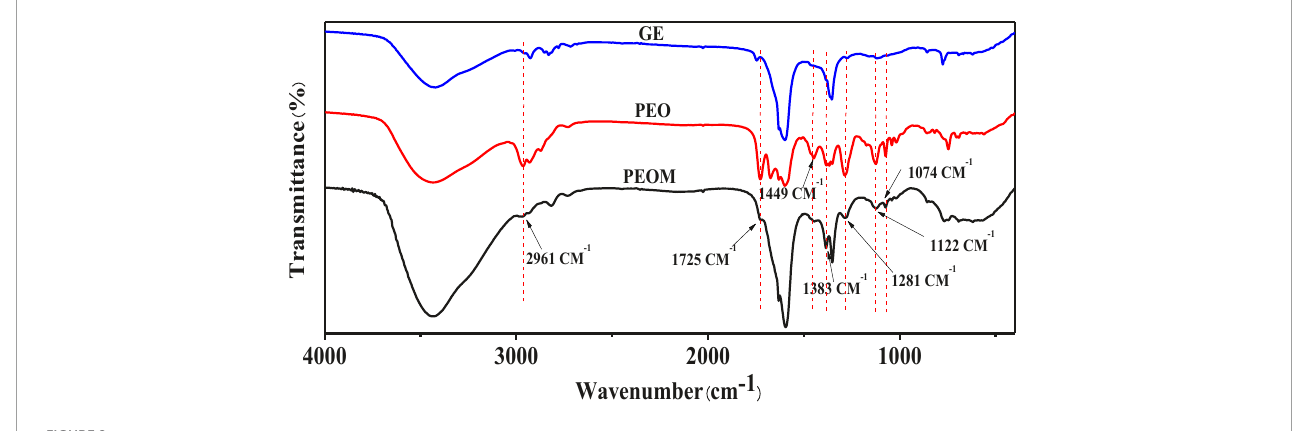
FIGURE2 Fourier Transform Infrared Spectroscopy (FTIR) spectroscopy of Perilla essential oil microcapsules (PEOM).